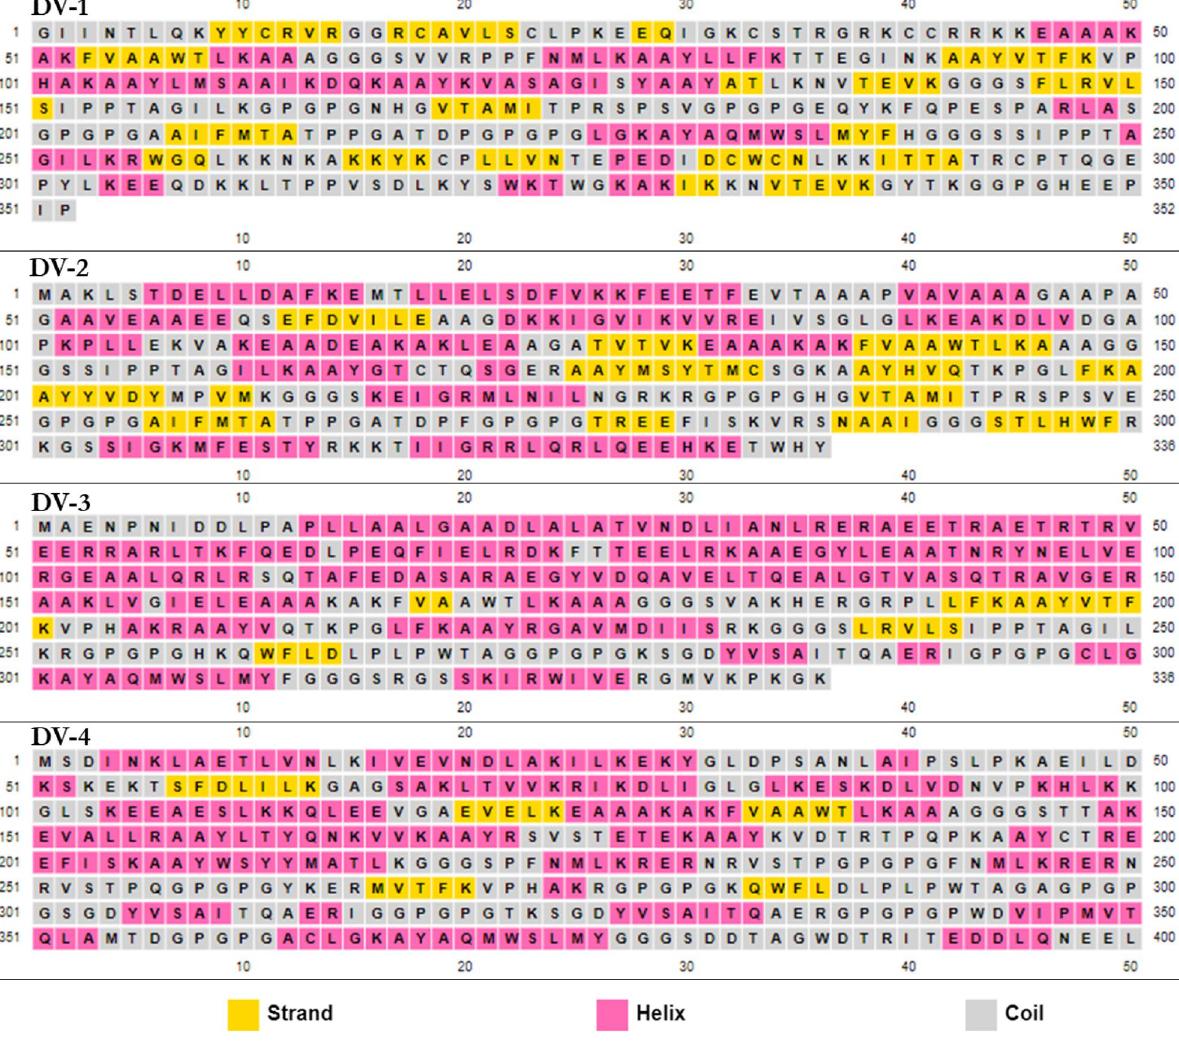
Figure 2. The secondary structures of the predicted dengue virus vaccines